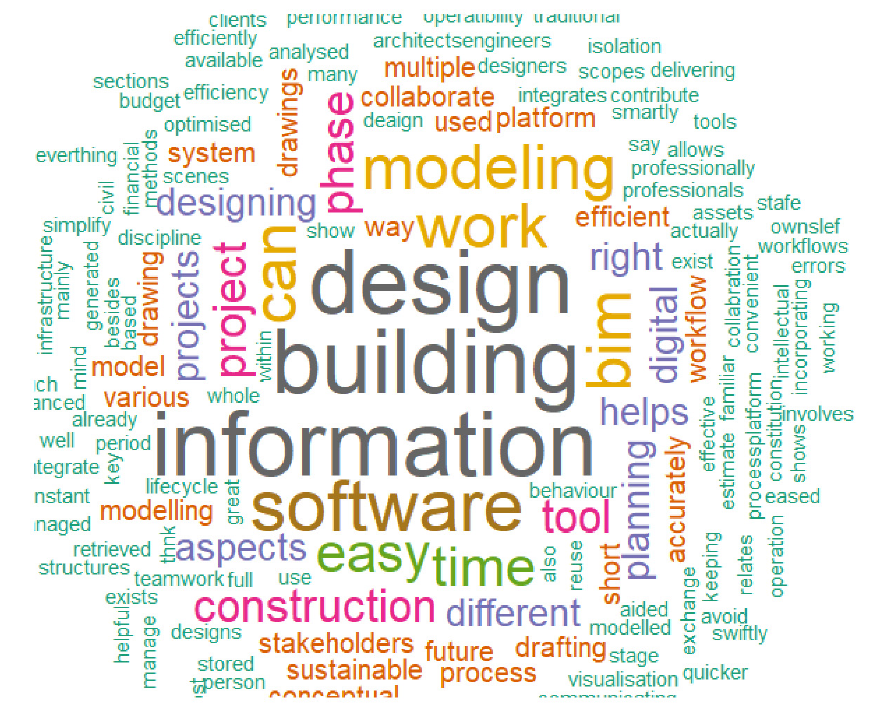
Figure 4. Understanding of BIM in Nepali AEC.